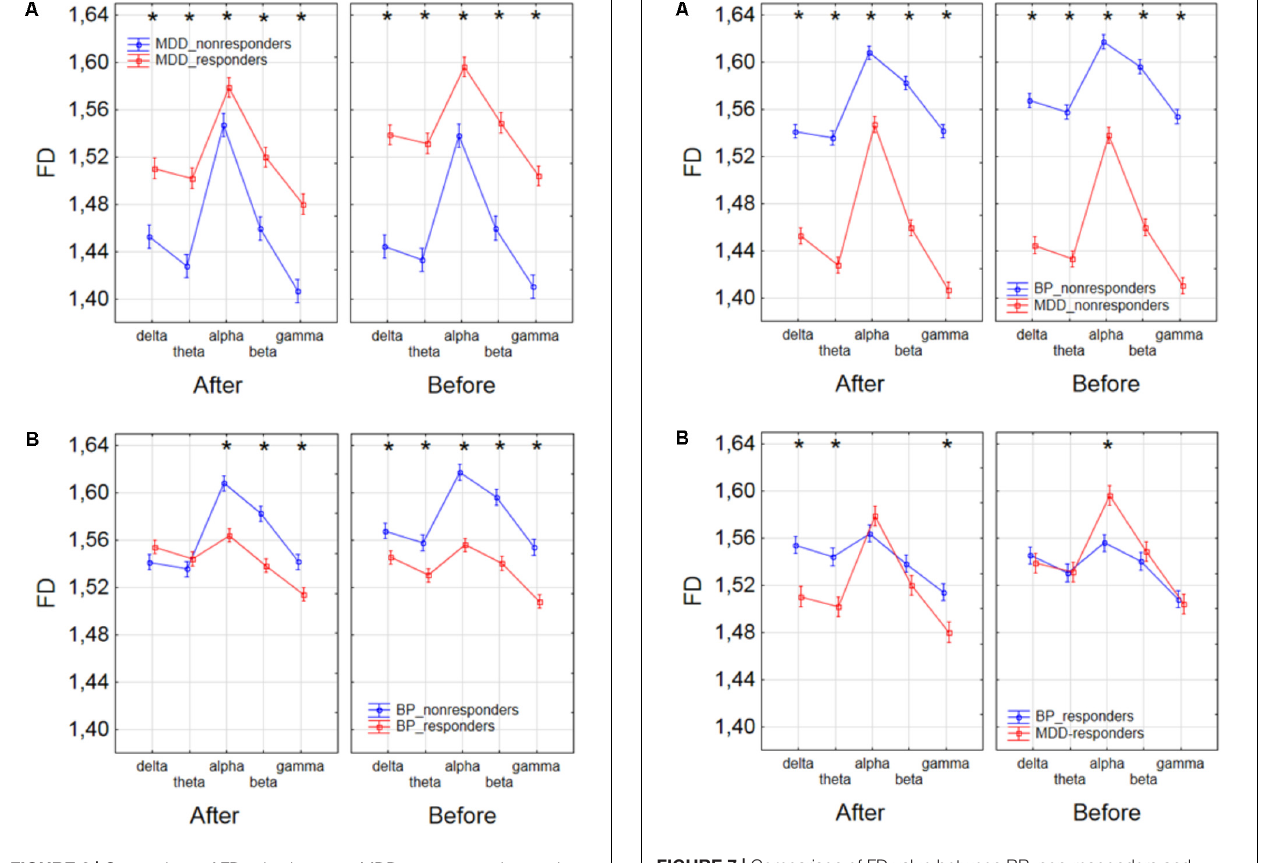
red lines in right panel with left panel in Figure 6A